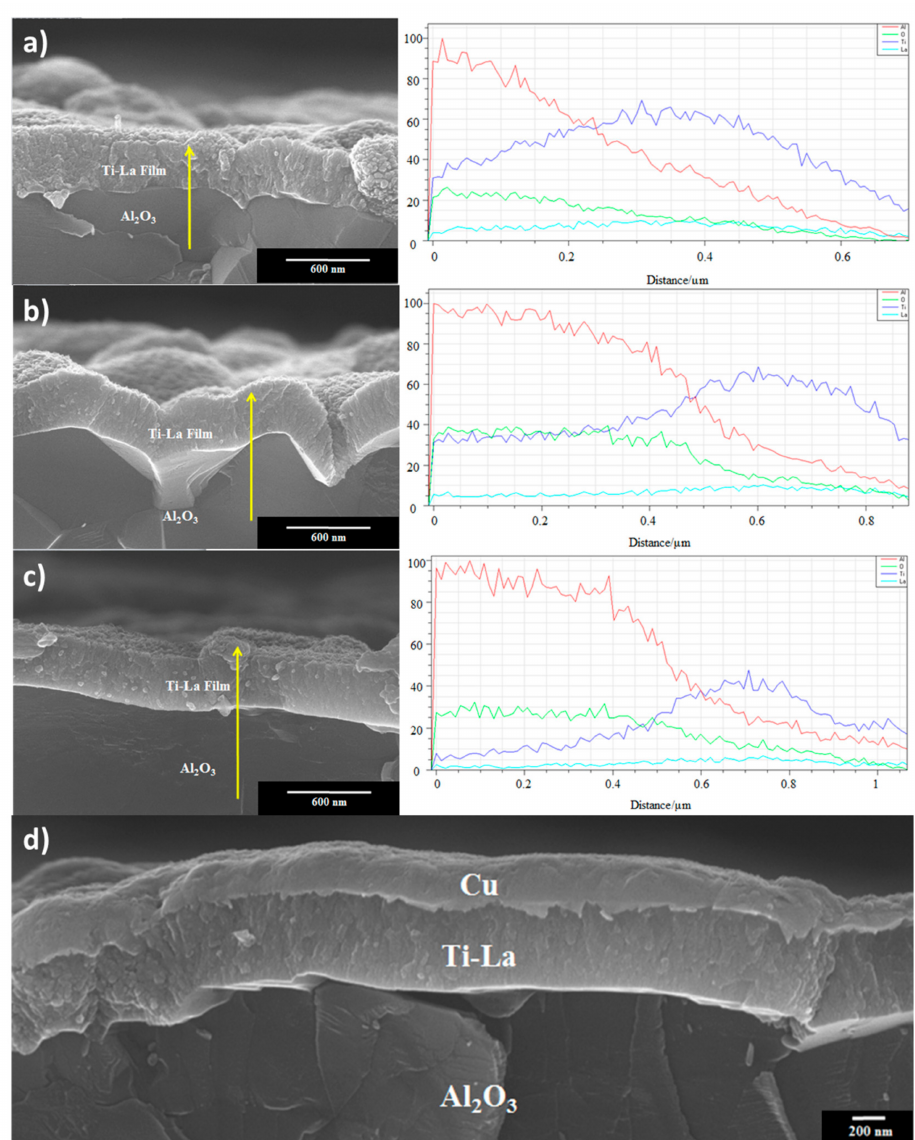
Figure 1. Cross-section images showing pre-metallization Ti–0.5La thin films on alumina substrates, with line scans. Samples were fabricated at process temperatures of ( a ) 250; ( b ) 300; and ( c ) 350 ◦ C; ( d ) thin film of pure copper are deposited on the Ti–0.5La thin film.